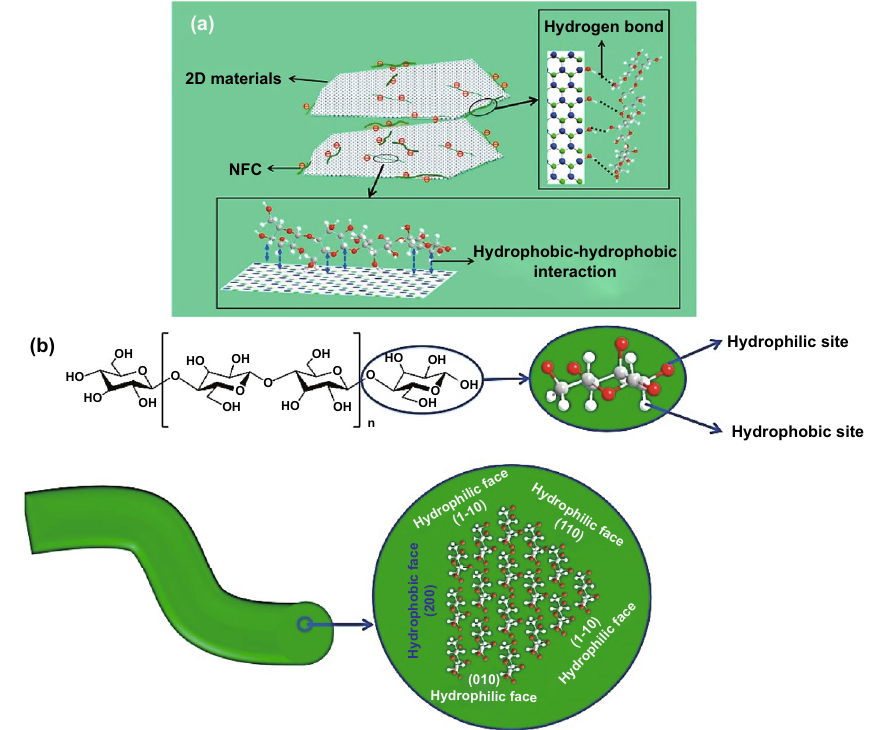
Fig. 7 a Schematic view of two-dimensional materials disperse by Nanocellulose. b Schematic view of hydrophilic–hydrophobic crystalline faces of cellulose. c Three-dimension chemical structure of cellulose displays the hydrophilic–hydrophobic sites. Reproduced with permission from Refs. [19, 169]. Copyright © 2015,